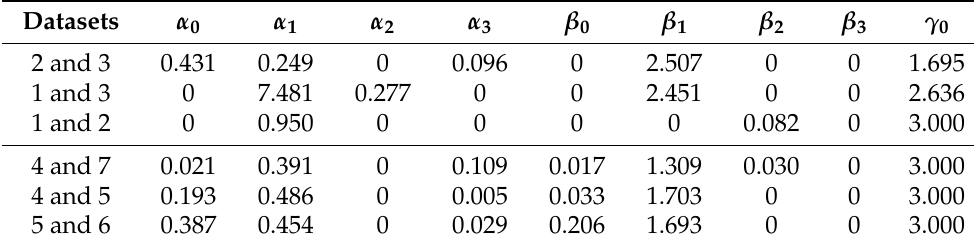
Table 6. Calibrated parameters in Scenario 2.